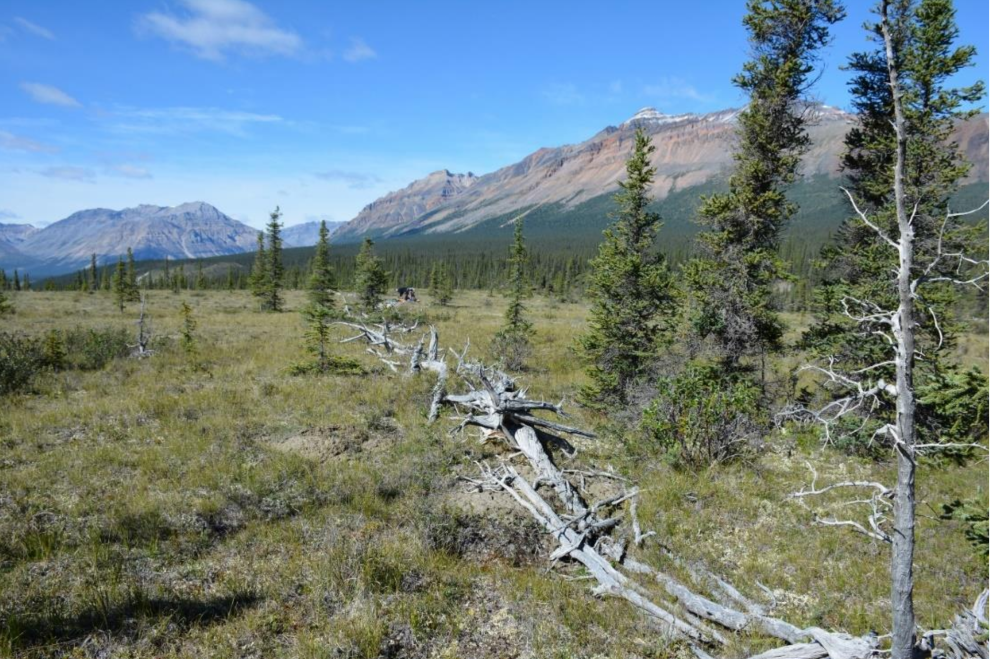
Figure 1. A section of the remains of the ≈ 800 m long mountain caribou fence structure with Stelfox Mountain in the